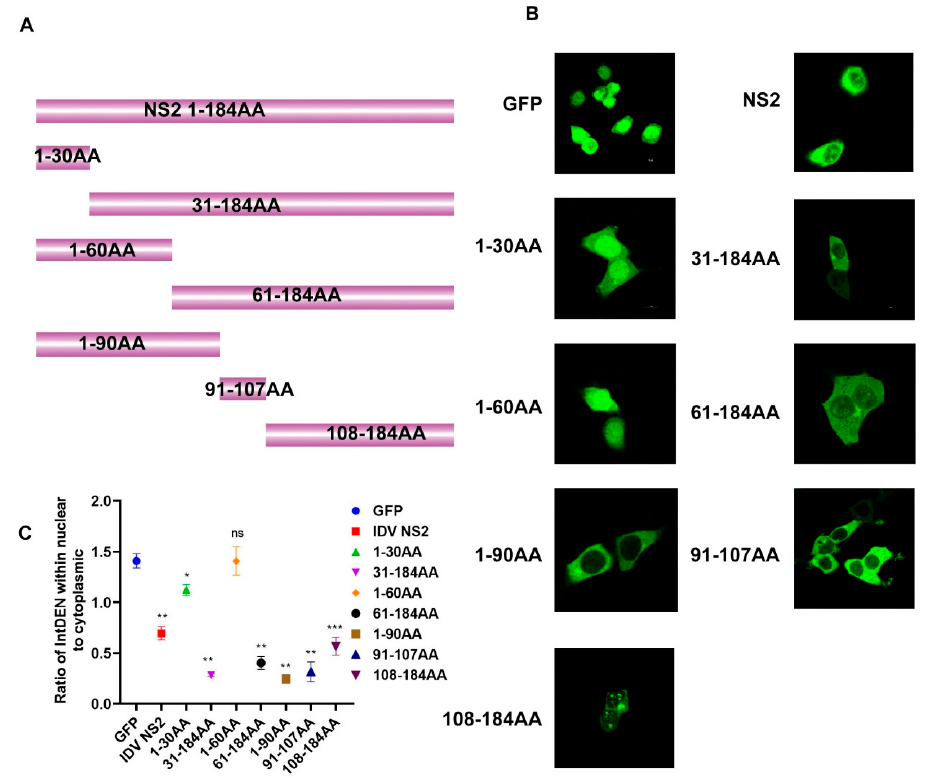
Figure 2. Mapping regions of nuclear export signals (NESs) of IDV NS2 protein. ( A ) Schematic representation of truncated constructs. ( B ) HEK293T cells were transfected with truncated constructs. ( C ) Quantification of fluorescence signal was performed in ImageJ. (Statistical di ff erences are labeled according to a one-way ANOVA followed by a Dunnett s test; ns = not significant, * p < 0.05, ** p < 0.01, *** p <